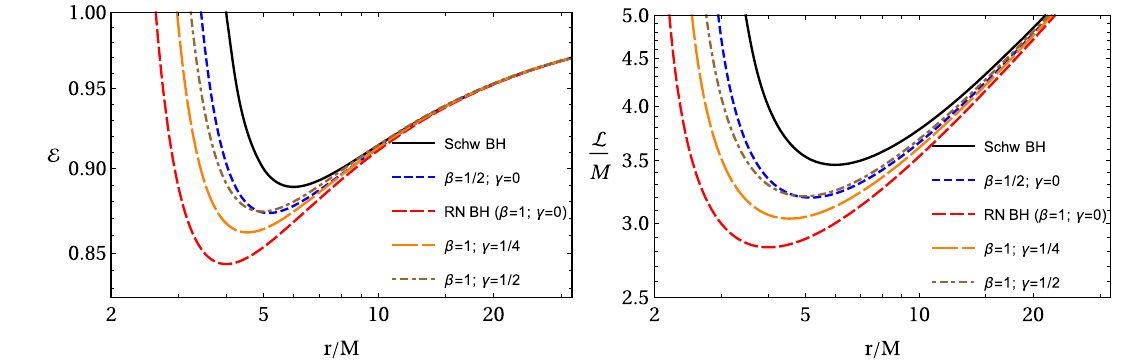
Fig. 4 The radial dependence of specific energy (left panel) and angular momentum (right panel) of test particles around EMS BHs for different values of the parameters β and γ